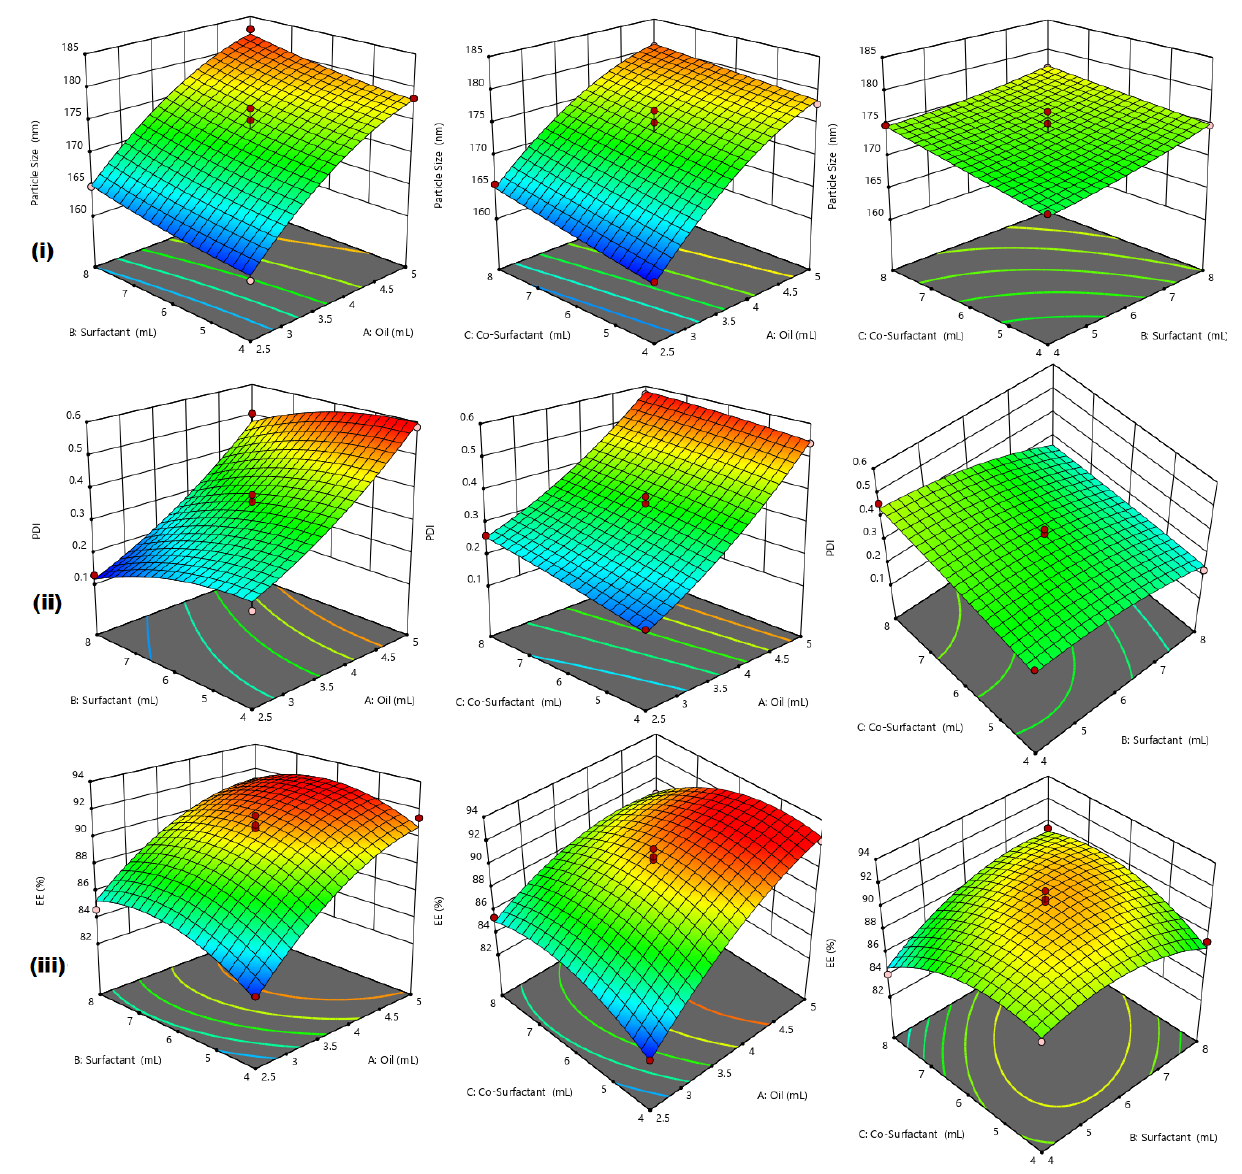
Figure 2. Three-dimensional plots obtained using Box–Behnken design showing effects of factors AB, BC and AC on ( i ) particle size, ( ii ) PDI and ( iii ) %EE.